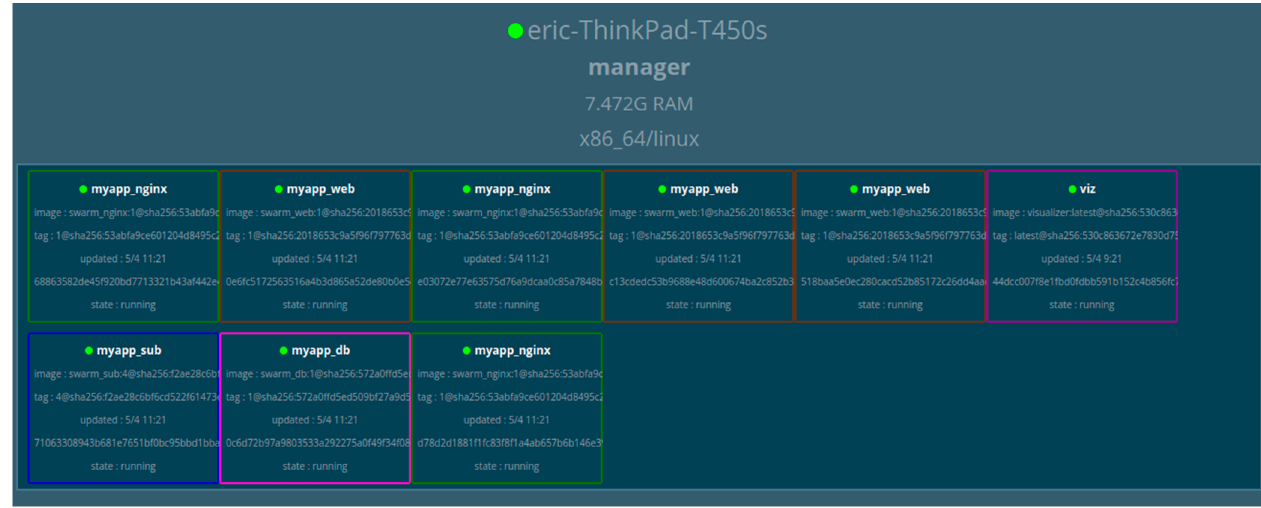
Figure 12. Docker Swarm with duplicated container services at the scale up purpose.